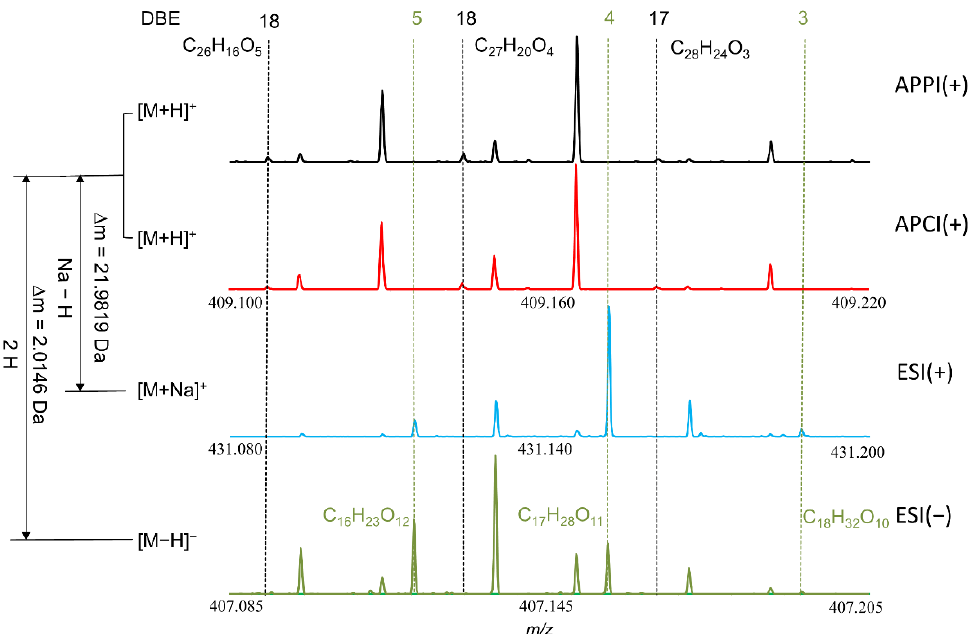
Figure 3. Mass scale-adjusted spectrum comparison, assuming the same elemental compositions to be observed as different types of ions by different ionization techniques: m/z range from 409.100 to 409.220 Da for APPI(+) and APCI(+), 431.080 to 431.200 Da for ESI(+) and 407.085 to 407.205 Da for ESI( − ). The mass differences between different types of ions are shown on the left.